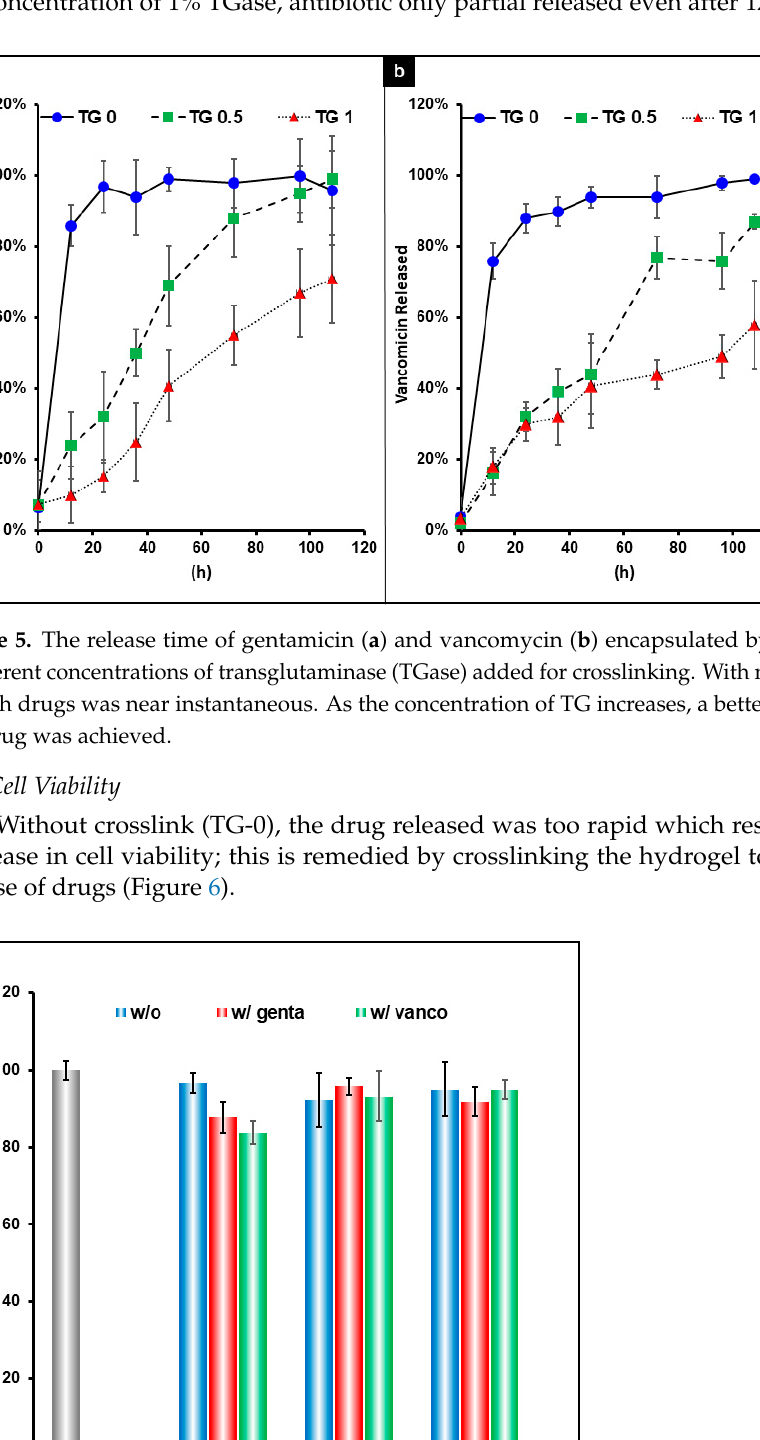
8 of 15 Figure 4. Electronic microscopic photos showing degree of crosslink of hydrogel with 3 different concentrations of transglutaminase (TGase) added. The surface becomes rougher and the cross section showed denser linkage as TGase concentration increase.